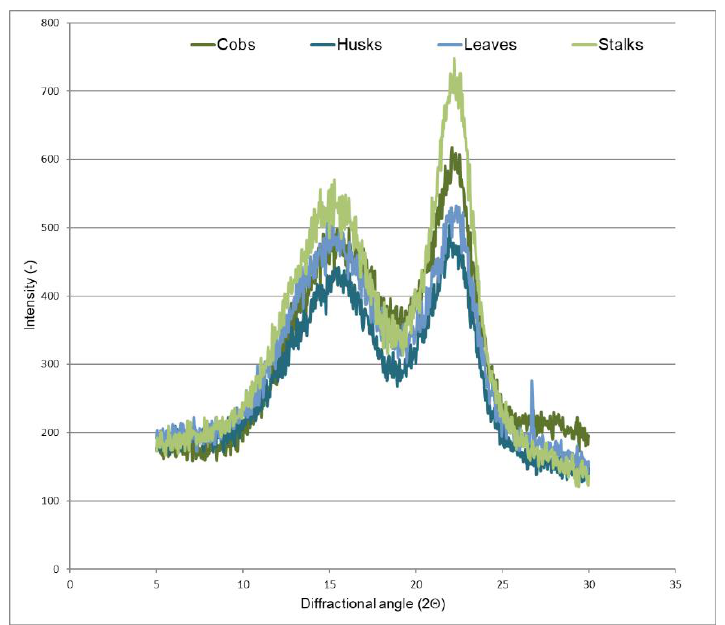
Figure 3. X-ray diffraction patterns of maize stover fractions.